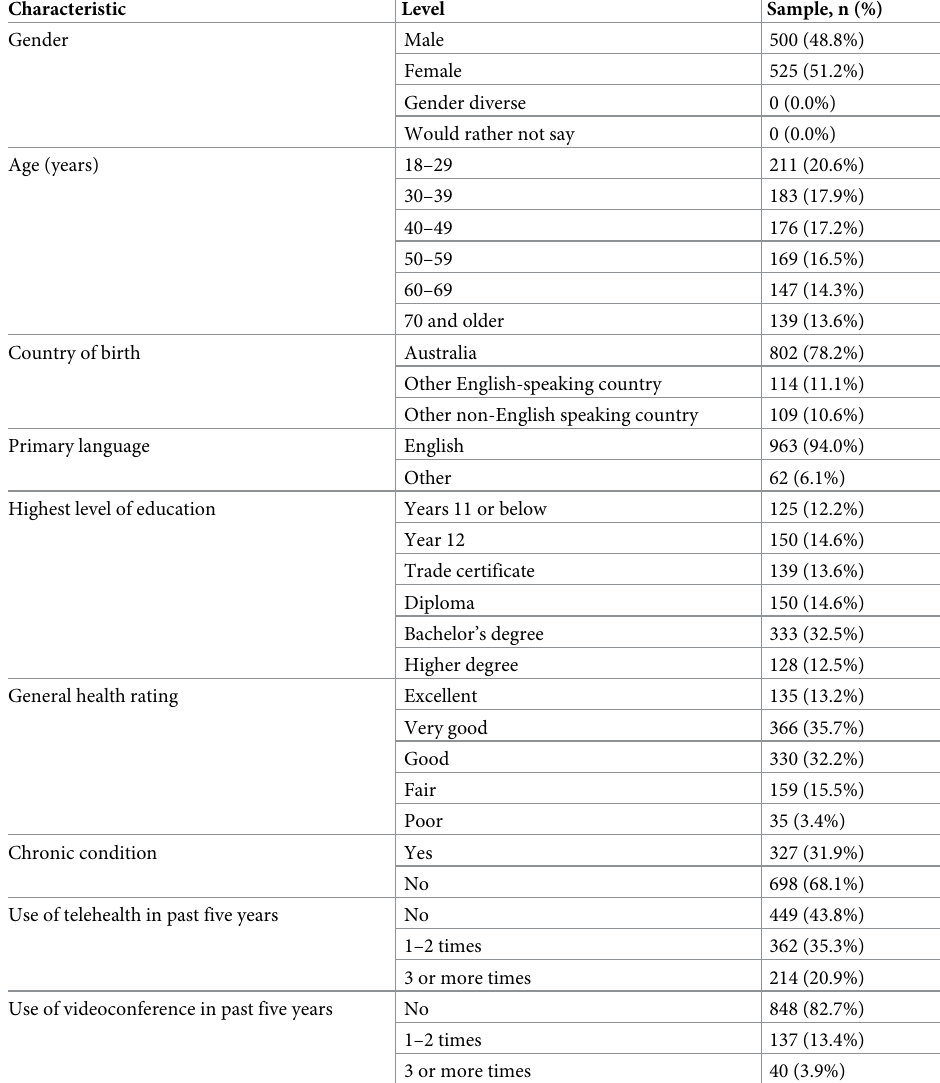
Table 2. Demographic